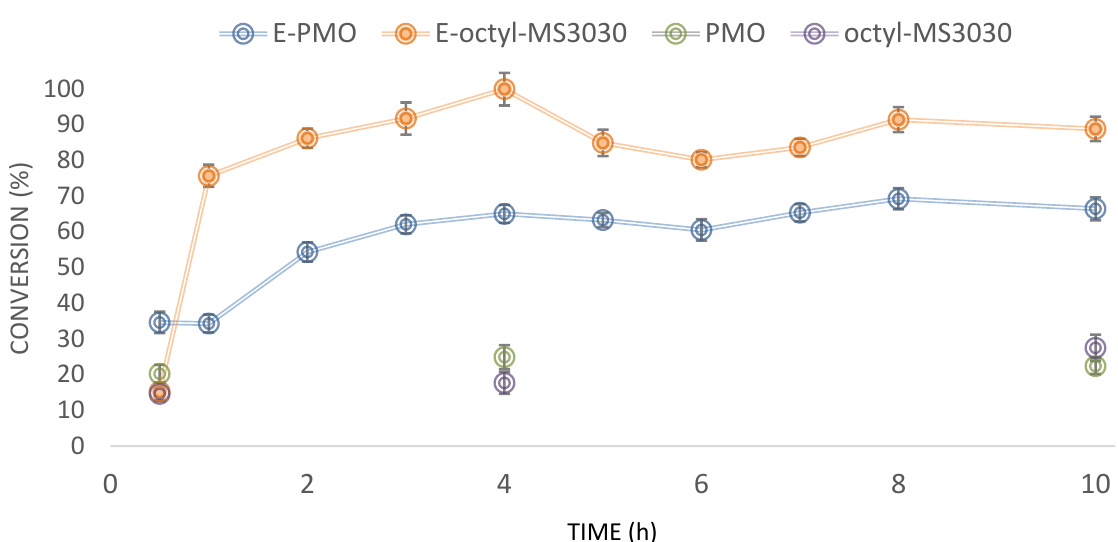
Figure 3. Study of the variation of conversion with time of reaction on the catalysts studied under the same experimental conditions as in Figure 2. Some conversion values obtained with the supports, without enzymatic load, have been also included.